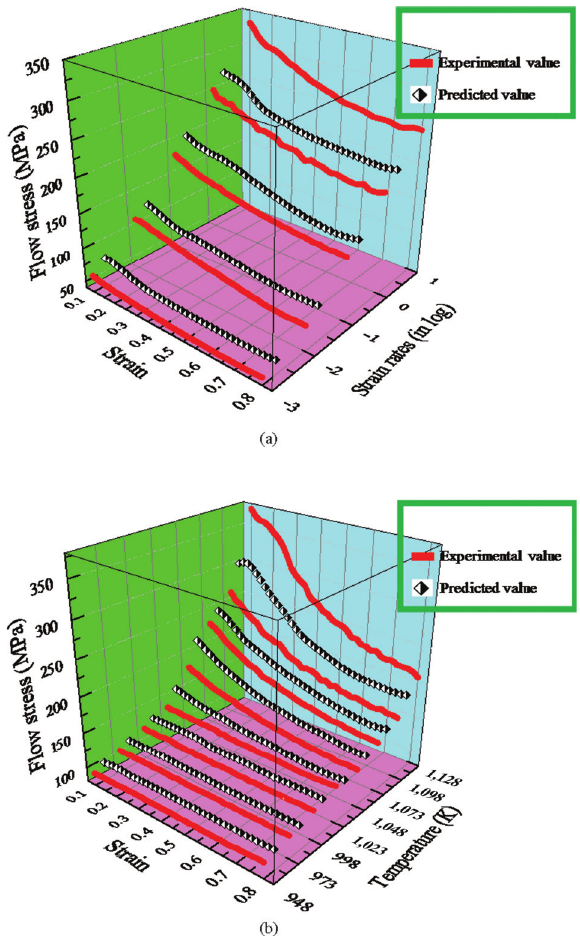
Figure 18 The 3D plot of flow stress at (a) temperature of 1,023 K under strain rates of 0.002 s − 1 to 2 s − 1 and (b) strain rate of 0.1 s − 1 under temperatures of 958 K to 1,108